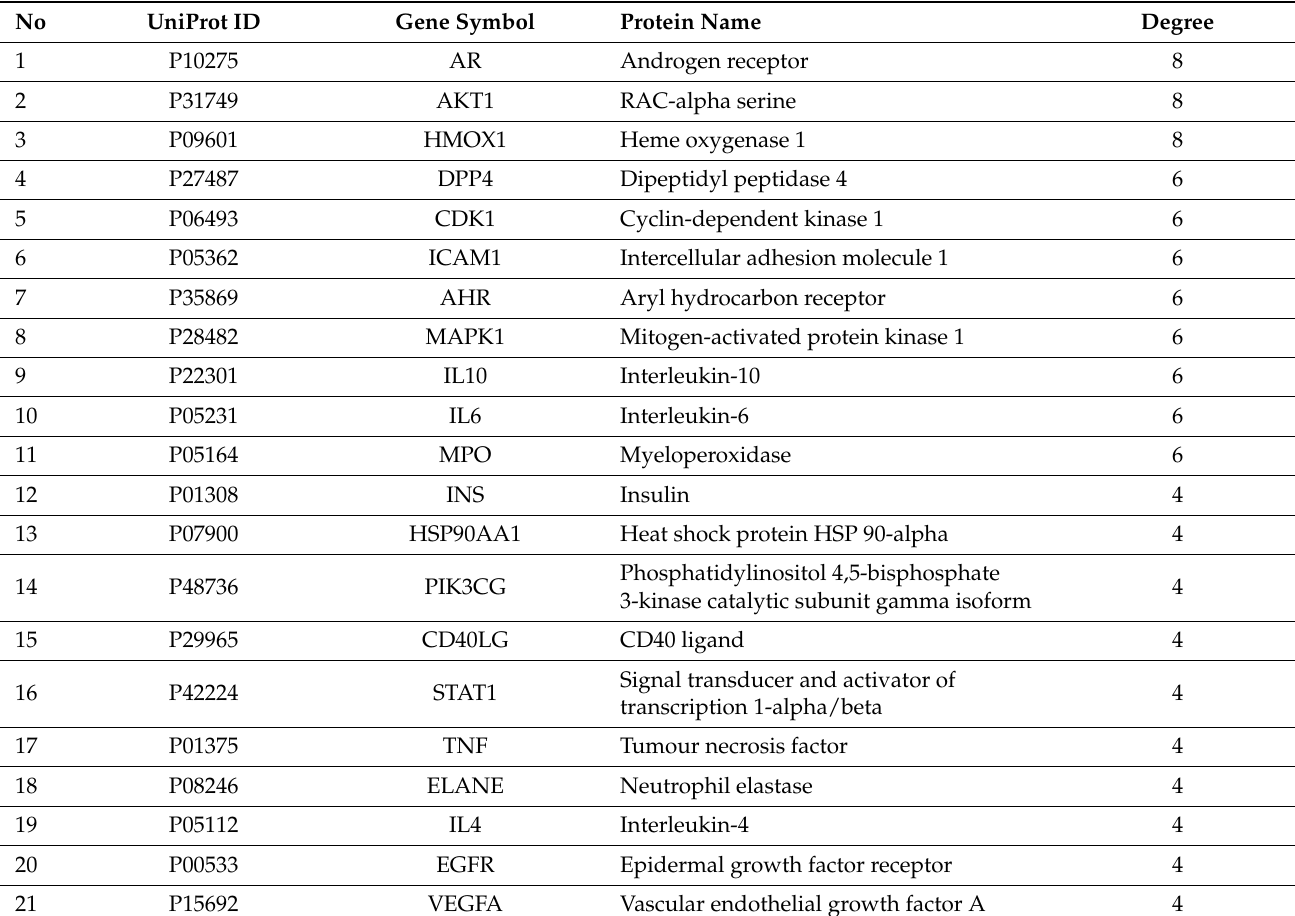
Table 2. Information of 21 core genes after protein–protein network